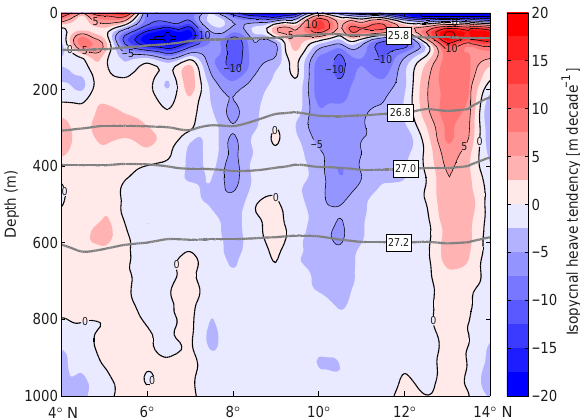
Figure 10. Depth–latitude section of the isopycnal heave tendency (filled contours) from shipboard observations along 23 ◦ W for the period 2006–2015 (positive values denote upward migration of isopycnal surfaces; see text for details of the calculation). Gray con- tours define average isopycnal